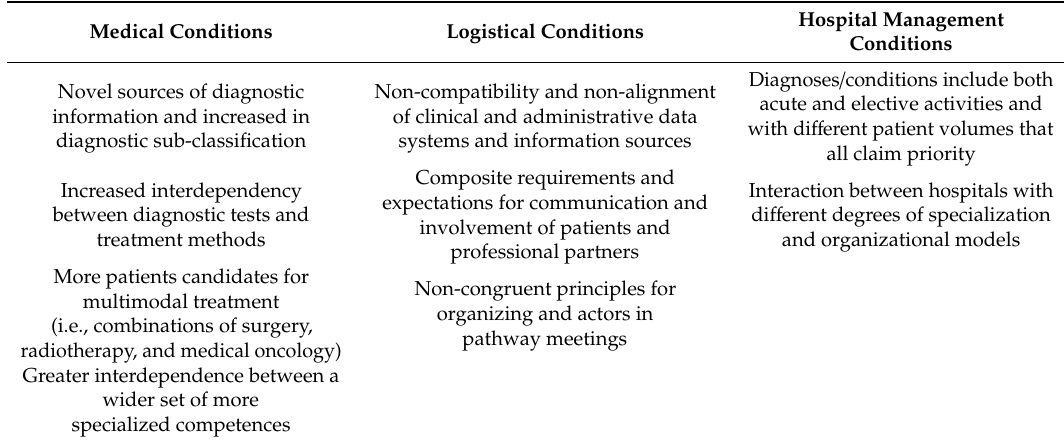
Table 2. Which conditions create complexity with regards to the coordination of the patient pathways?